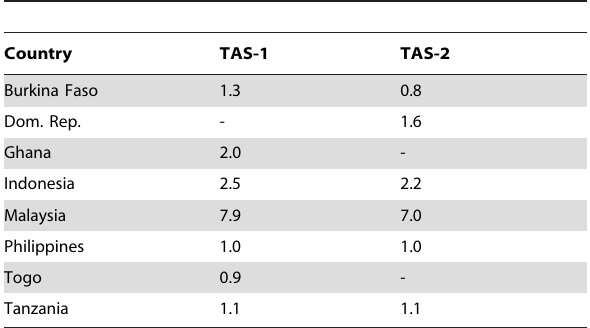
Table 10. Number of field days required to complete TAS-1 and TAS-2.